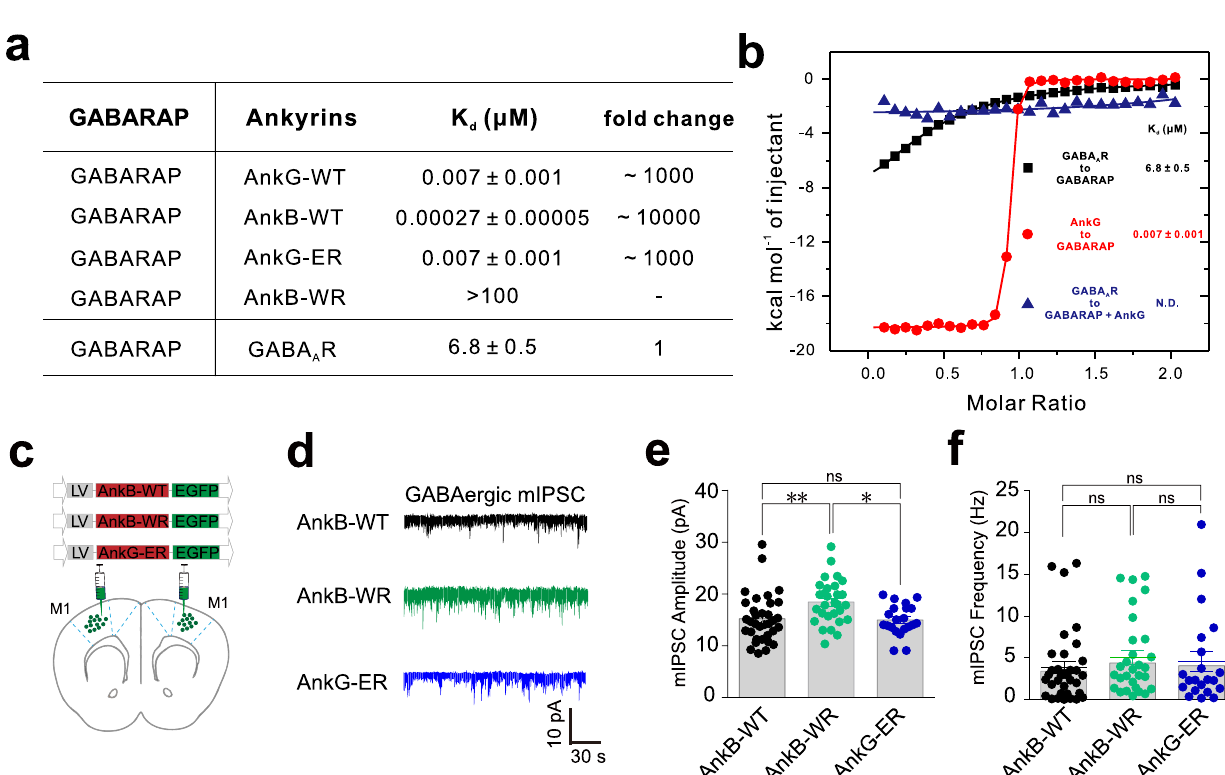
Fig. 7 In vivo disruption of GABARAP – GABA A R complex formation in M1 pyramidal neurons deleteriously impacts GABAergic synaptic activity. a The measured binding af fi nities between various giant ankyrin peptides and GABARAP based on ITC and comparison against γ 2-GIM in binding with GABARAP. b ITC-derived binding curves comparing the binding af fi nities between γ 2-GIM and GABARAP or GABARAP – AnkG WT peptide complex. c Schematic diagram for in vivo experiments, showing the site of lentivirus injection for peptide expression and patch clamp recording. d – f Representative trace records d , average amplitude e , and average frequency f of GABAergic mIPSCs in primary motor cortex slices from male C56/BL mice. Data are represented as the mean ± SEM. n = 34, 29, and 21 of each group (from left to right) in e and n = 34, 29, and 21 of each group (from left to right) in f . ** P = 0.0079, AnkB-WT vs. AnkB-WR; * P = 0.0124, AnkB-WR vs. AnkG-ER based on one-way ANOVA; ns not signi fi cant ( P >